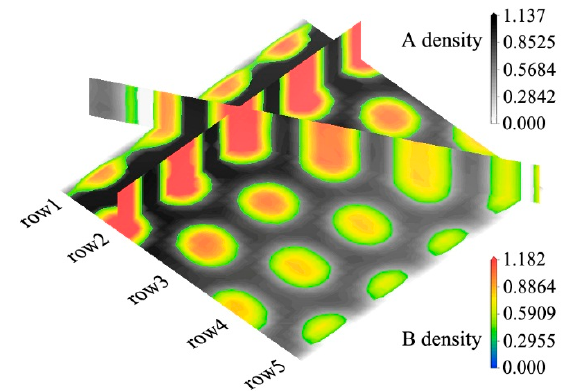
Figure 6. An equilibrium mesoscopic structure under YW55 confinement is extracted and specified by three characteristic density slices, with one along the X–Y plane, another through all cylindrical axes in row 2, and the third traversing individual cylindrical axes from every row. The color mappings of A and B beads are in white-black and reverse rainbow, respectively.